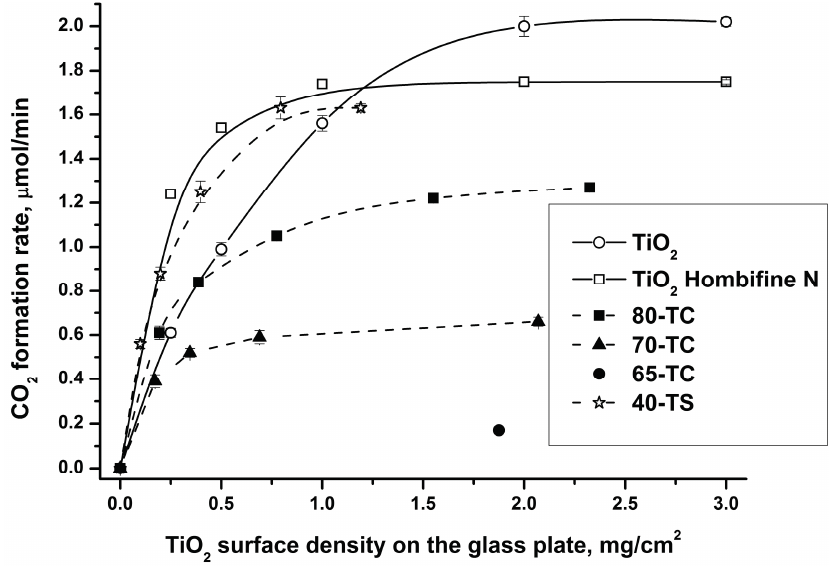
Figure 4. Influence of the quantity of photocatalyst on its photocatalytic